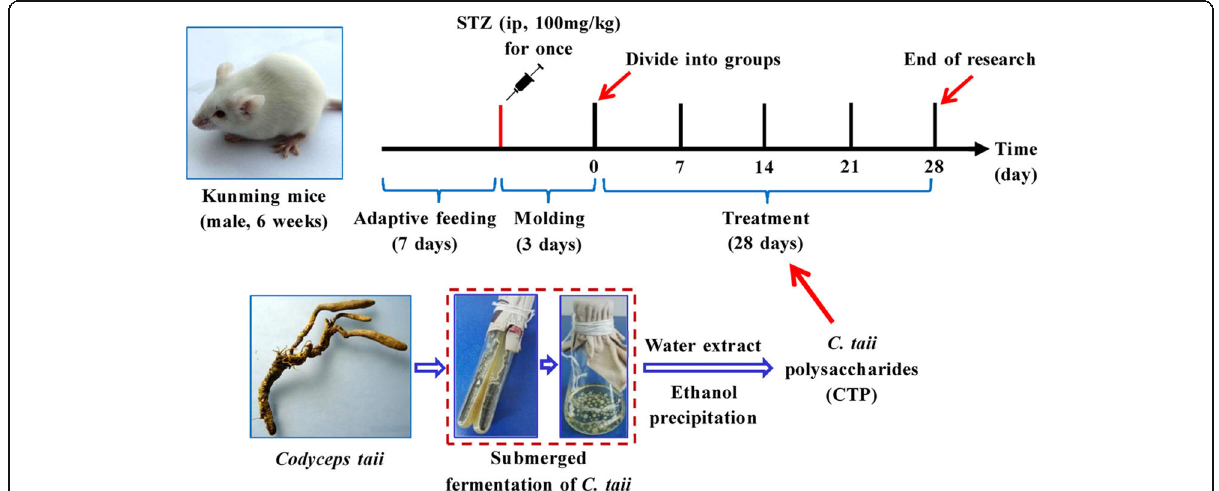
Fig. 1 Schematic of the treatment schedule. Adult male Kunming mice (6 weeks old) underwent adapted feeding for 7 days. Except in the CON group, all of the mice were ip injected with 100 mg/kg bw STZ (dissolved in an ice-cold 0.1 mol/L sodium citrate buffer) once. DM mice (fasting blood glucose concentrations higher than 11.1 mmol/L) were randomly divided into five groups after 3 days of modeling: diabetes mellitus group (DM), metformin-treated group (MET), and CTP (CTP-L, CTP-M and CTP-H) group. All of the mice were dosed by gavage once daily for 28 consecutive